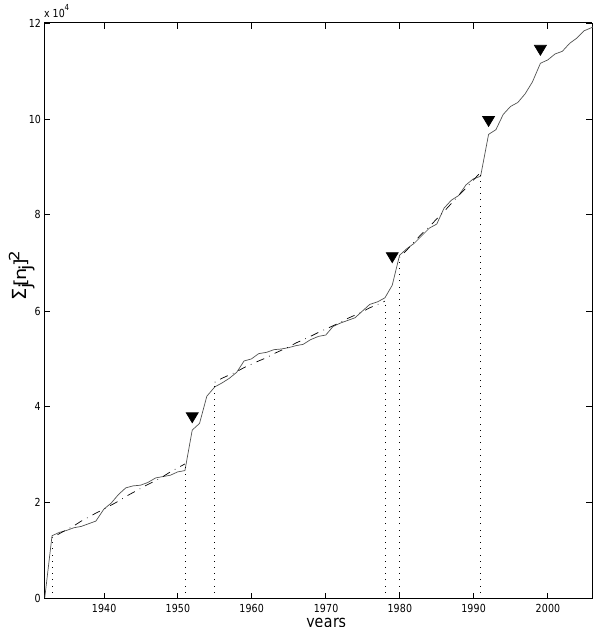
Fig. 3. Plot of Eq. (4) for the southern California dataset from 1932 to 2006. Dash-dot lines are linear regressions for the three effective ergodic periods from 1933 to 1951, from 1955 to 1978, and from 1980 to 1991. Upside triangles locate the years of the occurrences of large earthquakes: the 1952 Kern County, the 1979 Imperial Valley, the 1992 Landers and the 1999 Hector Mine.